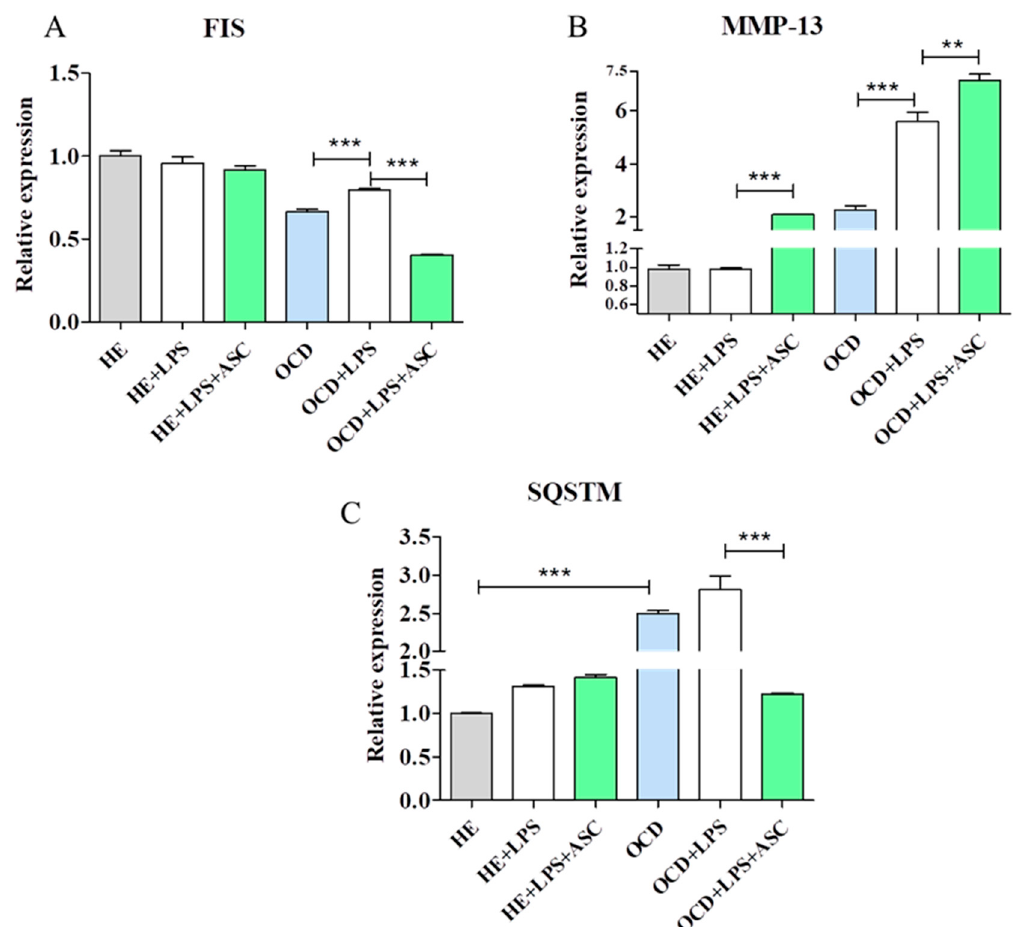
Figure 8. FIS, MMP-13 and SQSTM expression in HE and OCD chondrocytes. Cells were treated with 1 µ g/mL LPS in monoculture or co-culture with ASC for 24 h. Then, cells were analysed by RT-PCR for FIS ( A ), MMP-13 ( B ) and SQSTM ( C ) expression. Results expressed as mean ± S.D. ** p < 0.01, *** p < 0.001.